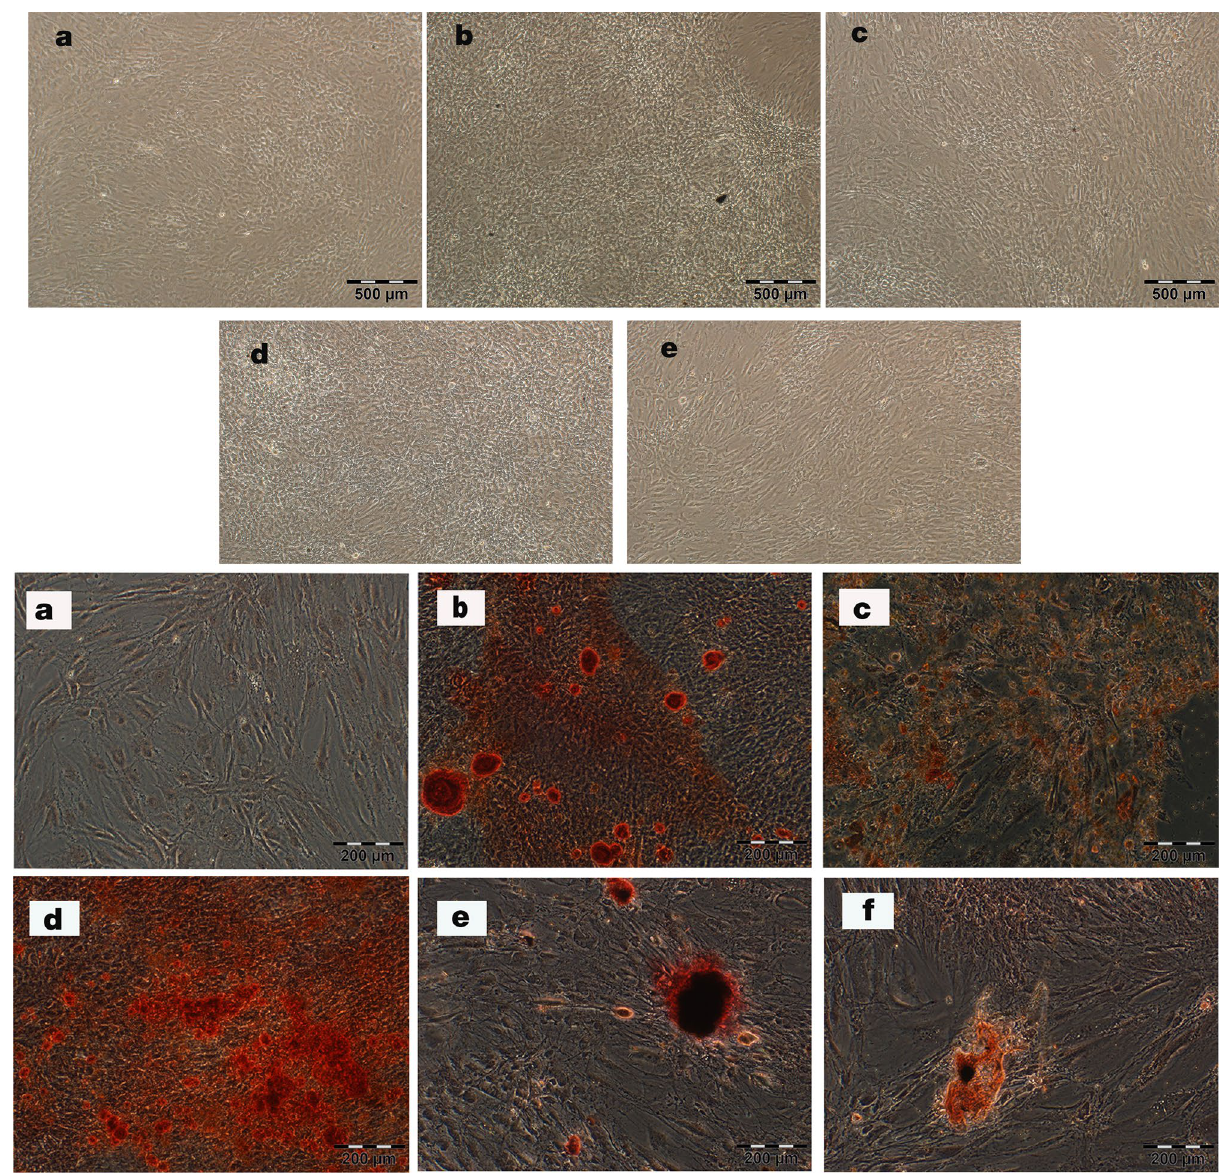
Figure 3. Top; Morphological analysis of hTERT-MSCs. Untreated cells ( a ), hTERT-MSCs-IFN-γ (250 U/ml) ( b ), hTERT-MSCs-poly(I:C) (20 µg/ml) ( c ), hTERT-MSCs-GFP ( d ), and hTERT-MSCs-co-transduced with IDO1 , PTGS2 and TGF‑β1 viral particles ( e ) upon reaching confluency (light microscope, Olympus, Japan, scale bars represent 500 µm). Bottom; Osteogenic differentiation of hTERT-MSCs. Untreated/unprimed hTERT- MSCs ( a ) or primed with differentiation inductive medium ( b ) were considered as controls. Cells primed in the permanent presence of IFN-γ (250 U/ml) ( c ), or poly(I:C) (20 µg/ml) ( d ), and following transduction with control GFP ( e ) or co-transduction with IDO1 , PTGS2 and TGF‑β1 viral particles ( f ) are shown. Alizarin red S staining is applied for detection of calcification after 21 days of induction (fluorescent microscope, Olympus, Japan, scale bars represent 200